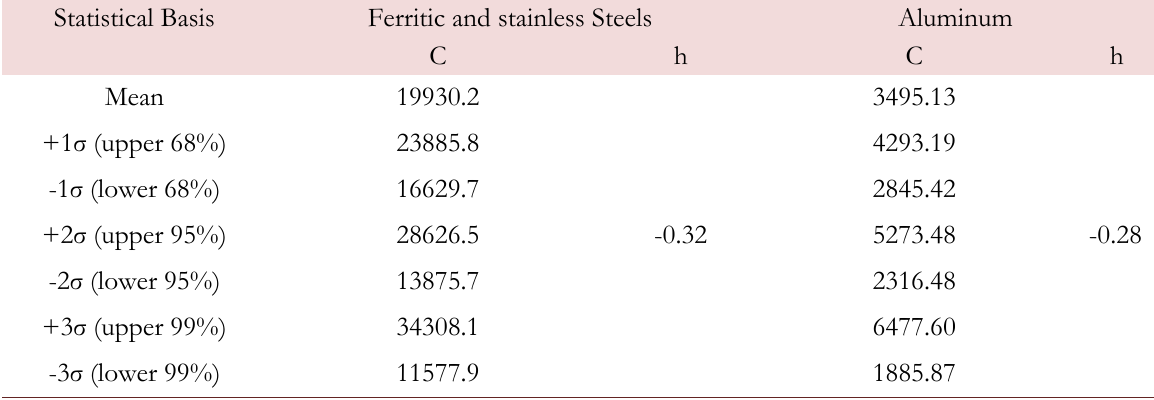
Table1: Coefficients of master S-N